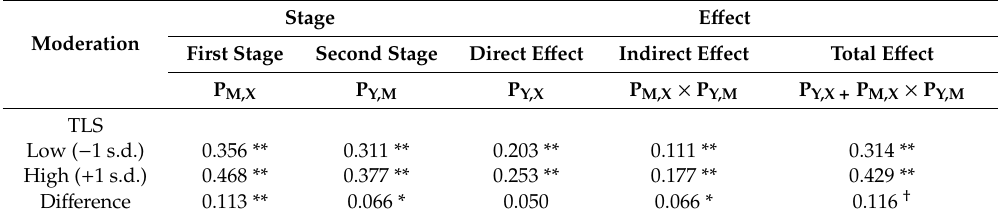
Table 7. The results of moderated mediation (mediating variable is work